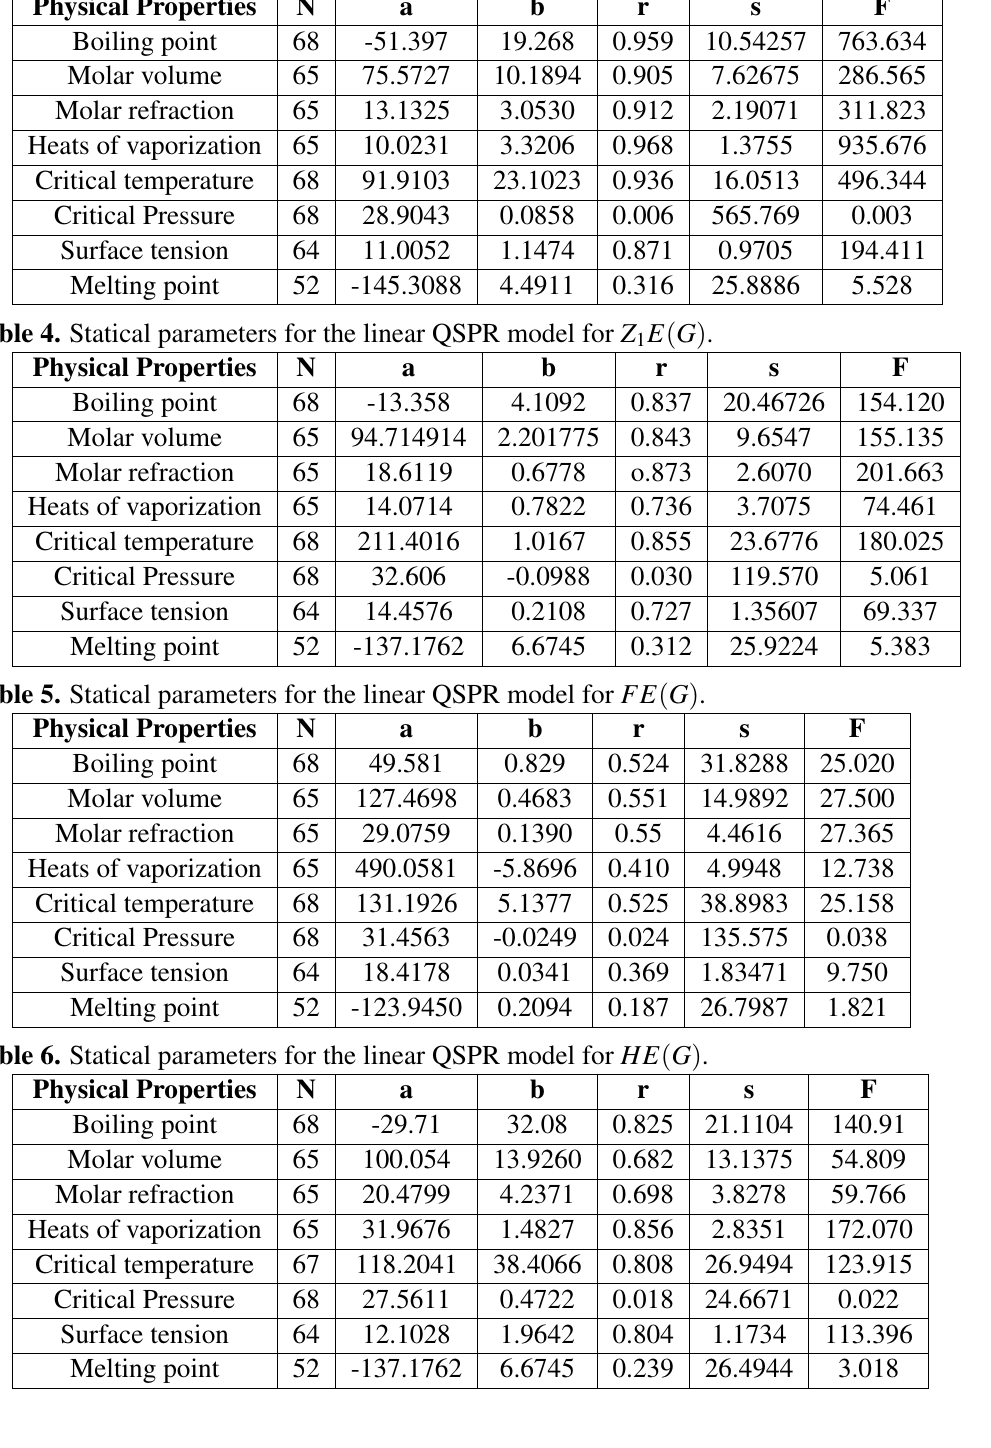
Table 3. Statical parameters for the linear QSPR model for E ( G ) .